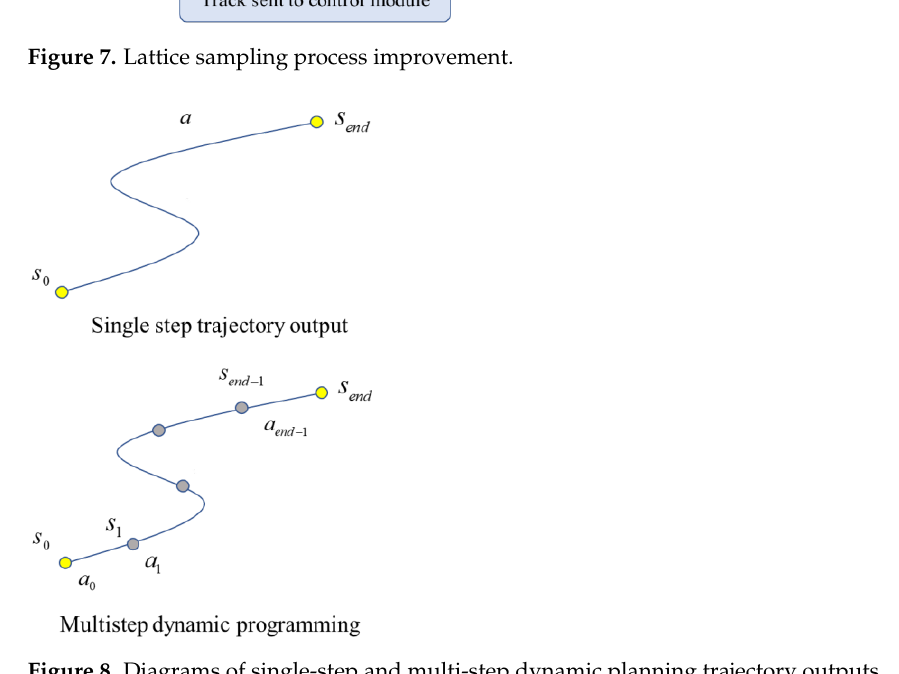
Figure 8. Diagrams of single-step and multi-step dynamic planning trajectory outputs.